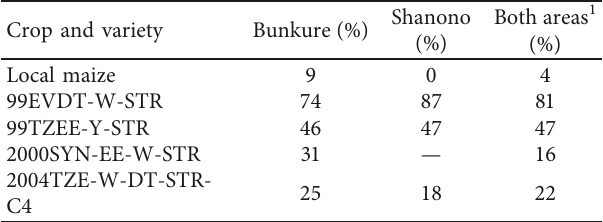
Table 6: Percentage of participants indicating which variety they intend to plant next season.